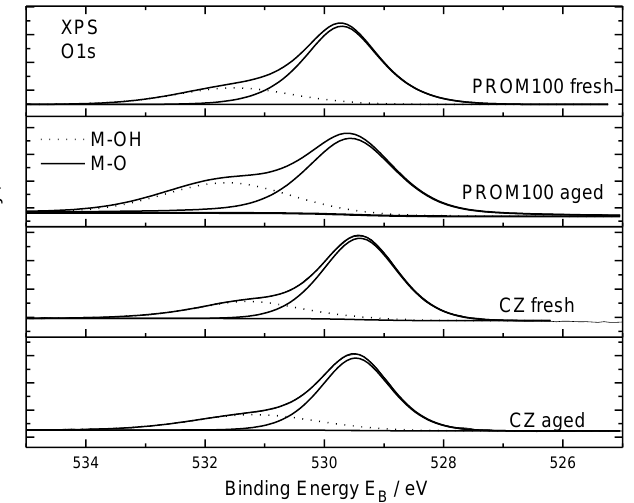
Figure 8. Deconvoluted O1s XP spectra of CZ carriers and PROM100-fresh and -aged. Table 3. XPS results of CZ and PROM100-fresh and -aged materials. If we compare the data between the surface technique (XPS) with the bulk techniques (EDX and XRF), we observe that the Pd is reduced on the surface but remains constant in the bulk as we move from the fresh to the aged samples. This indicates that the Pd is incorporated into the catalyst particle in the aged samples due to a sintering